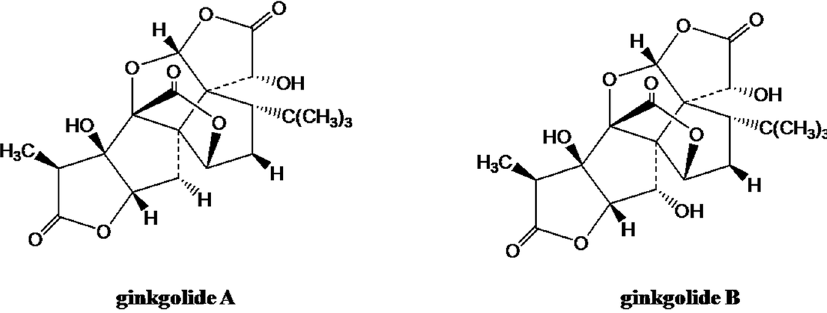
Figure 3. Ginkgolides A and B (adapted from Reference [81]).